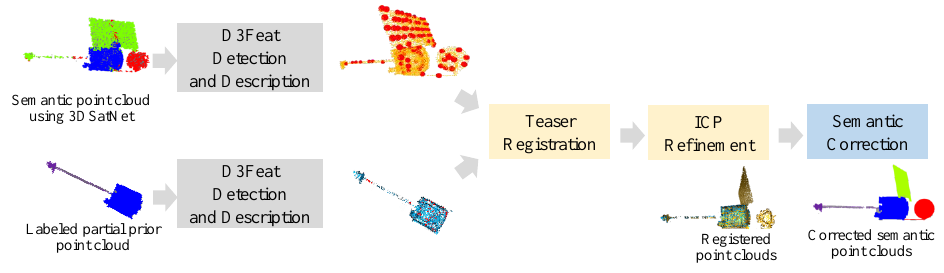
Figure 13. Pipeline of the proposed 3DSatNet-Reg